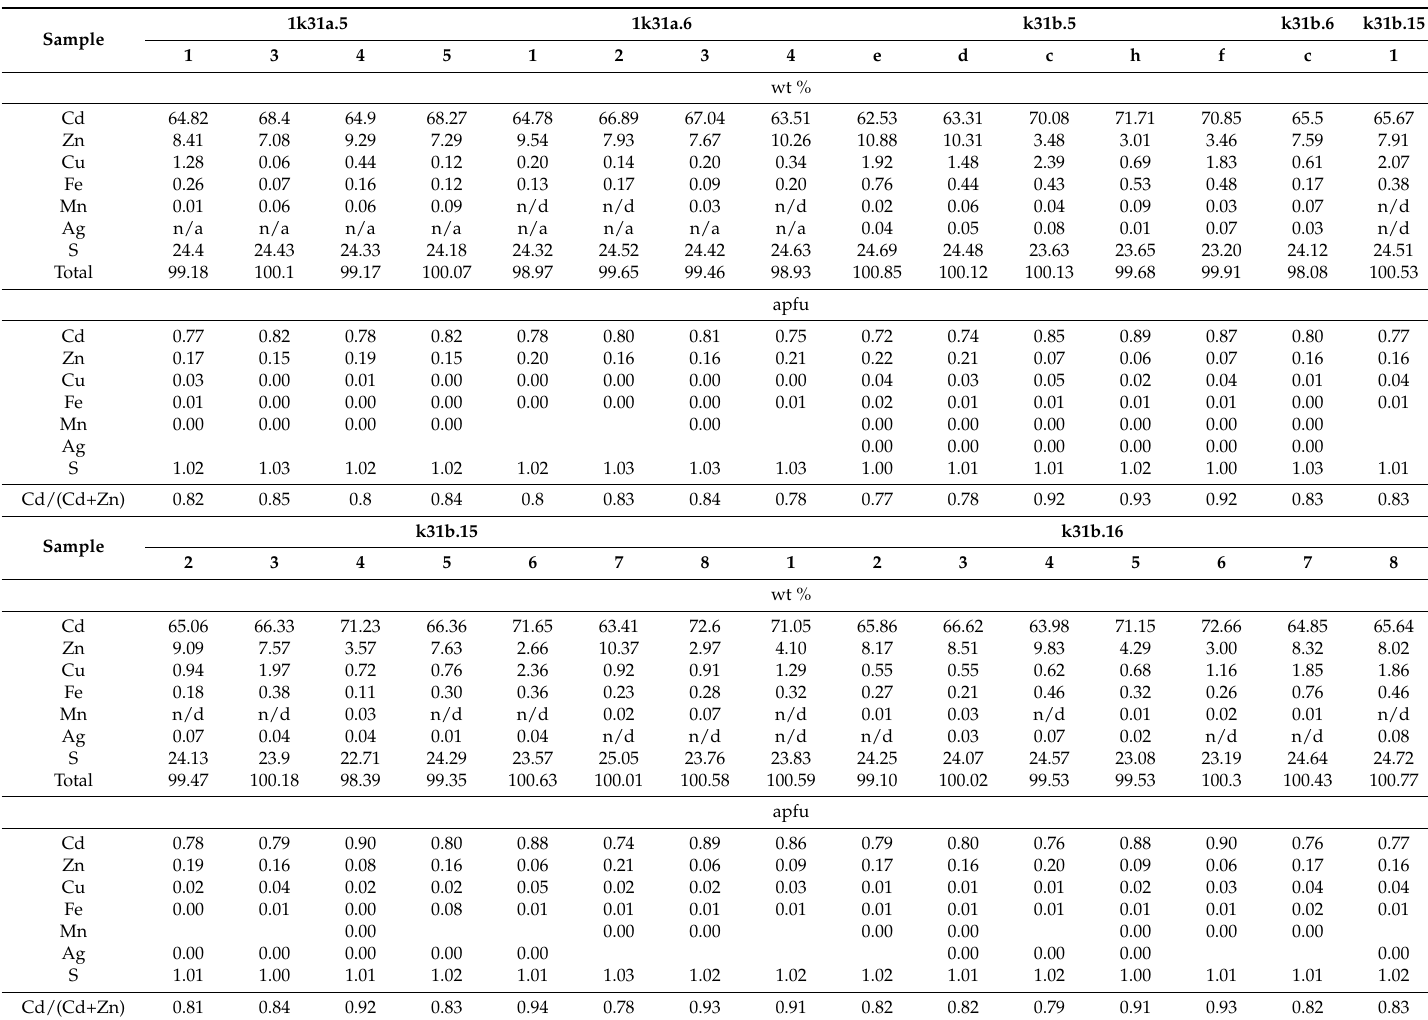
Table 1. EPMA data and atomic proportions of zincian greenockite. n/a: not analyzed; n/d: not detected; apfu: atoms per formula